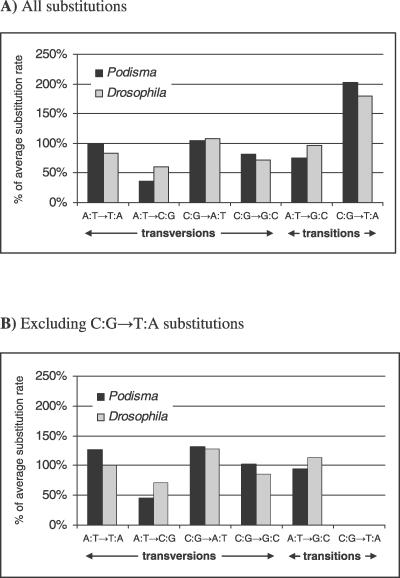
Neutral Point Substitution Patterns in the Grasshopper Podisma and the Fruit Fly Drosophila
Frequency of the different point substitutions in Podisma (black) and Drosophila (grey) (data from Petrov and Hartl [9]) expressed as a percentage of the average substitution rate.